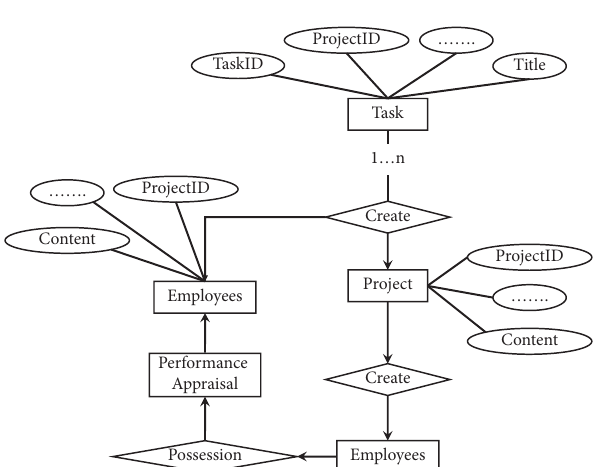
Figure 2: Data mining algorithm classification chart.